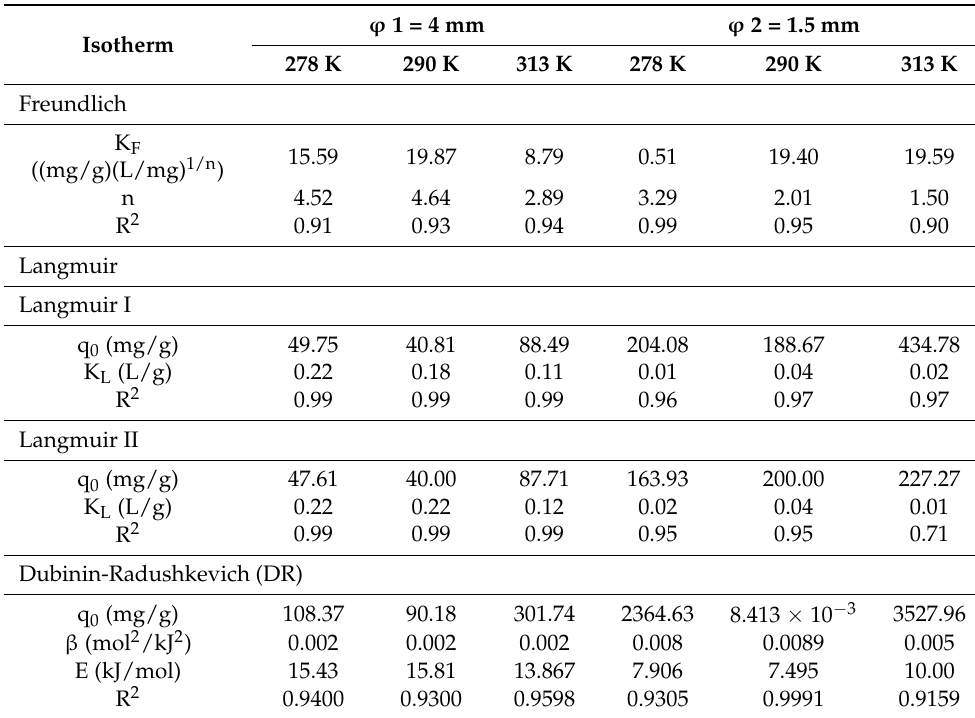
by encapsulation using a Buchi microencapsulator (Table 2). These values were